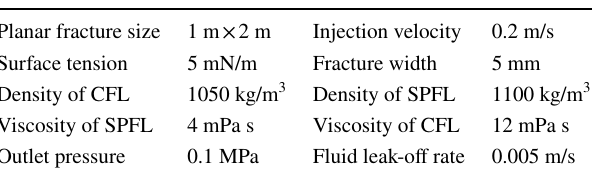
Fig. 3 Results of physical simu- lation experiments